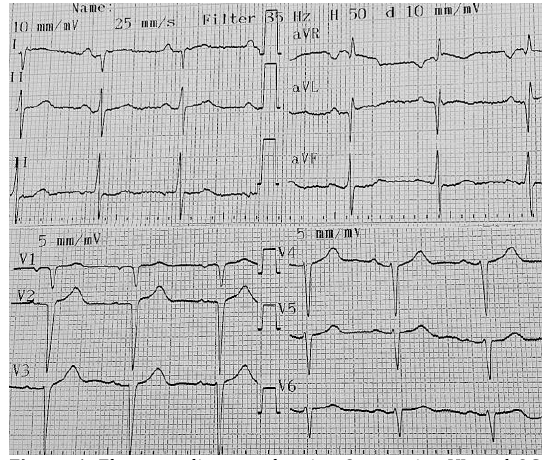
Figure 1. Electrocardiogram showing Q wave in aVL and QS in V1-V5 leads